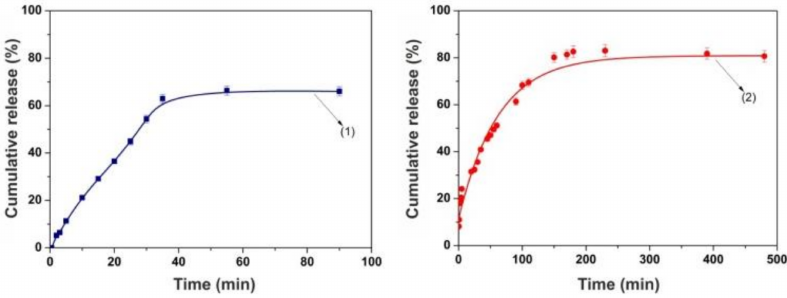
Figure 7. The cumulative release (%) of triclosan from CNC_TR (left) and CNC_TiO 2 _TR (right).